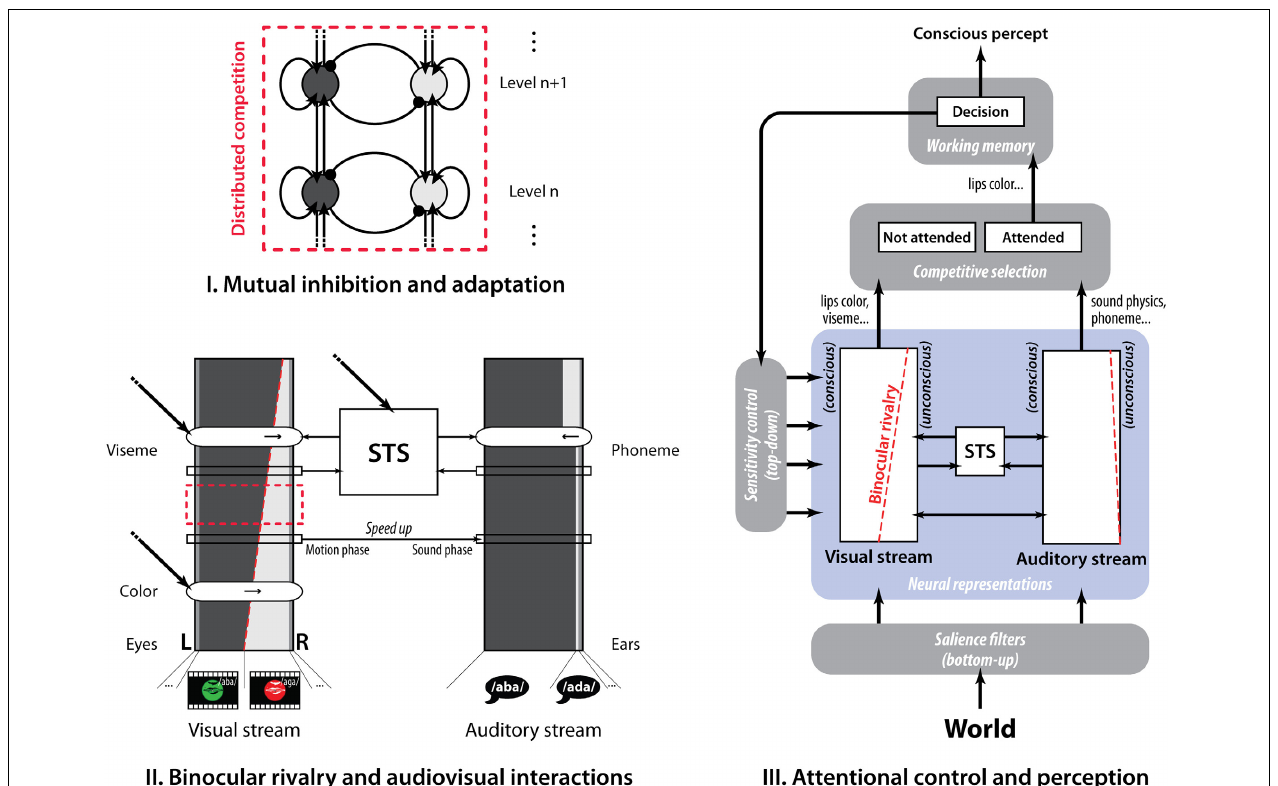
FIGURE 5 | A three-level descriptive framework based on existing models. (I) Hierarchical view of binocular rivalry in which mutual inhibition and adaptation of the neural populations coding each perceptual state governs the competition. (II) Speech audiovisual interactions in STS directly